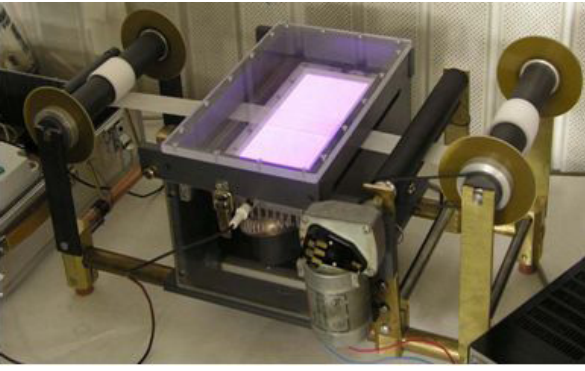
Figure 1: DCSBD reactor for continuous fabric treatment operating in nitrogen at atmospheric